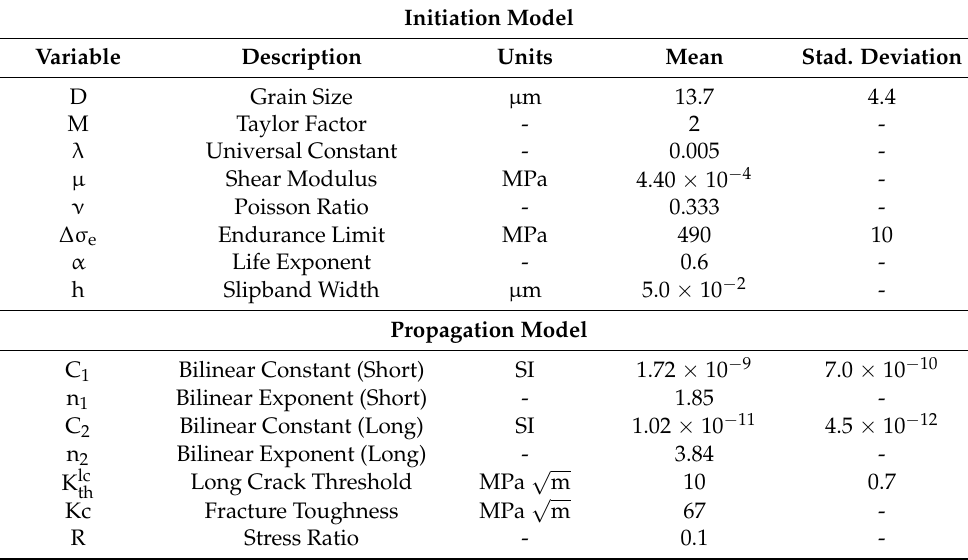
Table 1. Ti-6Al-4V material Properties for fatigue